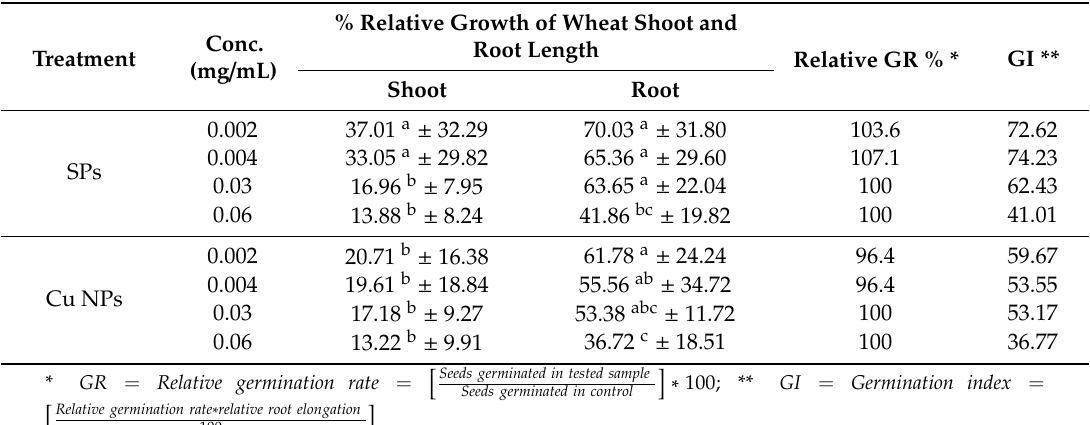
Table 3. E ff ect of SPs and Cu NPs on percentage relative growth of shoot and root lengths, germination rate and germination index of wheat